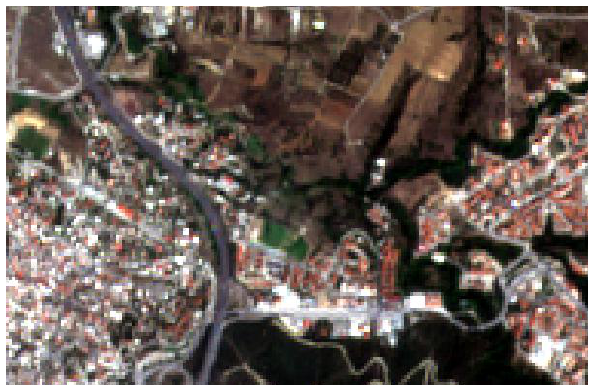
Figure 2. Subset of Landsat-8 image. Pixel size:30m